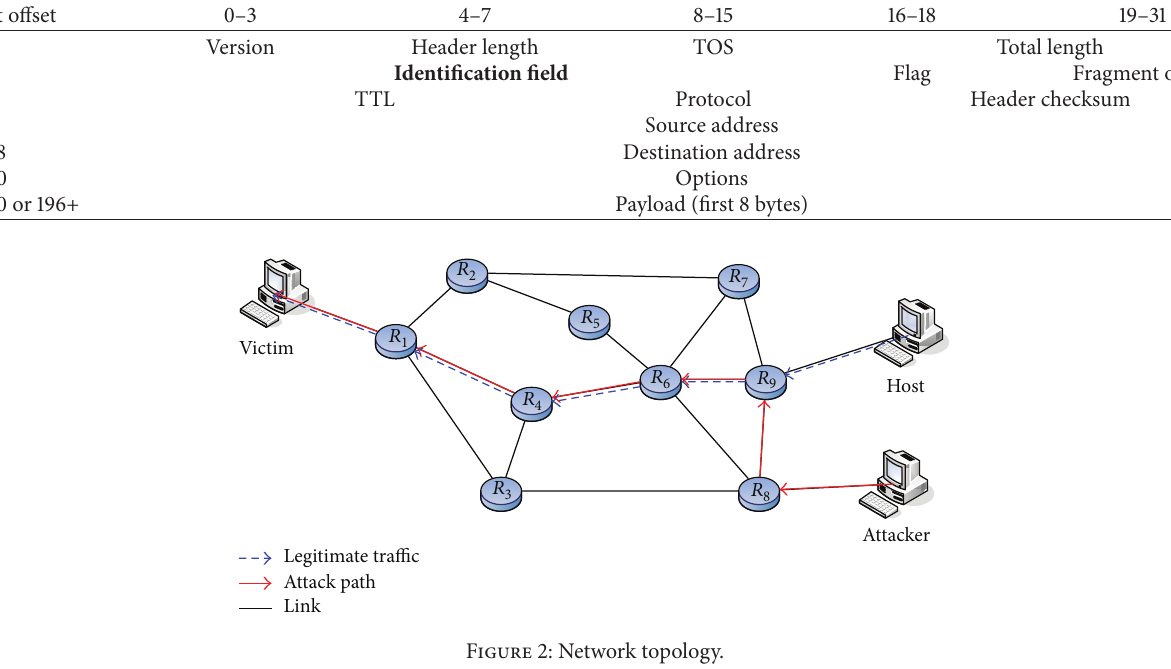
Table 1: IP header; Identification field is used for our packet marking.